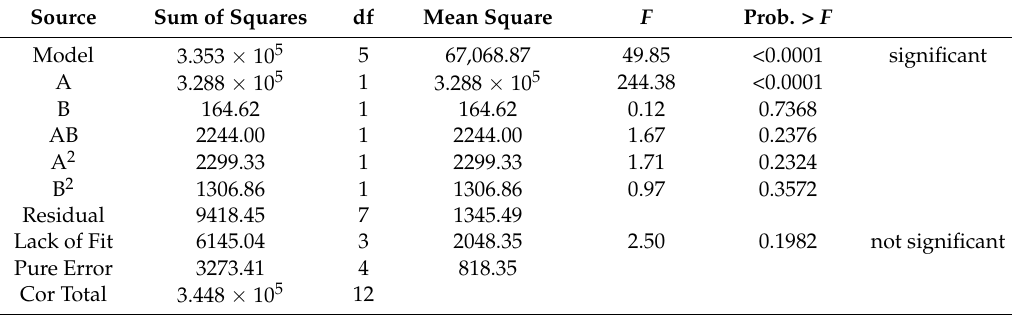
Table 4. Analyses of variance (ANOVA) for response surface model for elasticity modulus of POM composites using